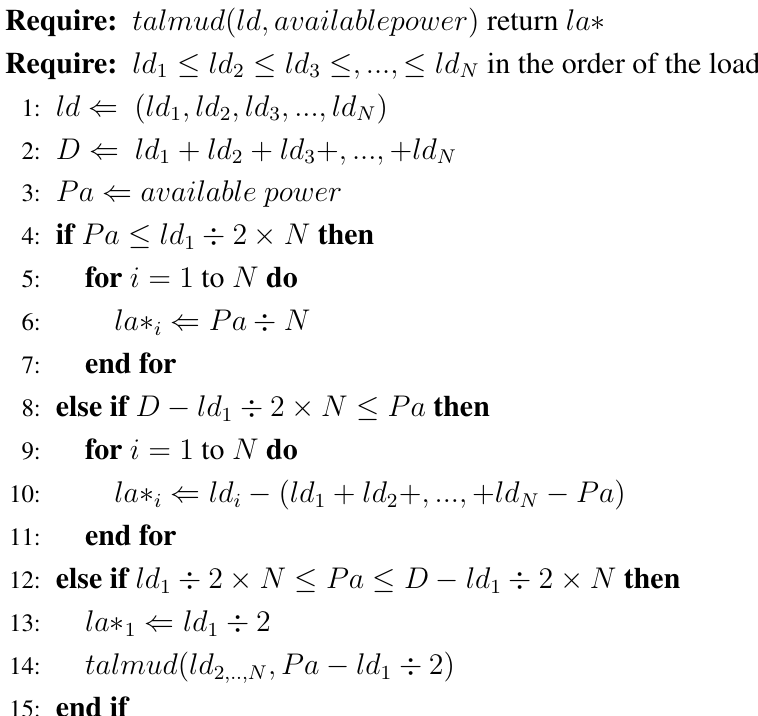
Algorithm 2 Talmud rule-based power allocation.